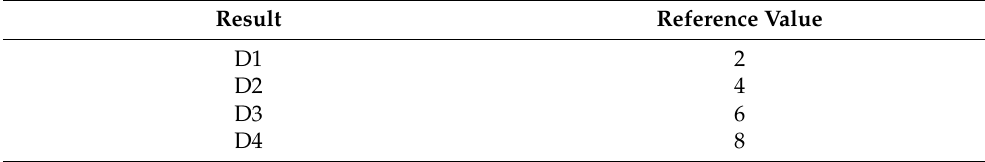
Table 3. Reference value of the